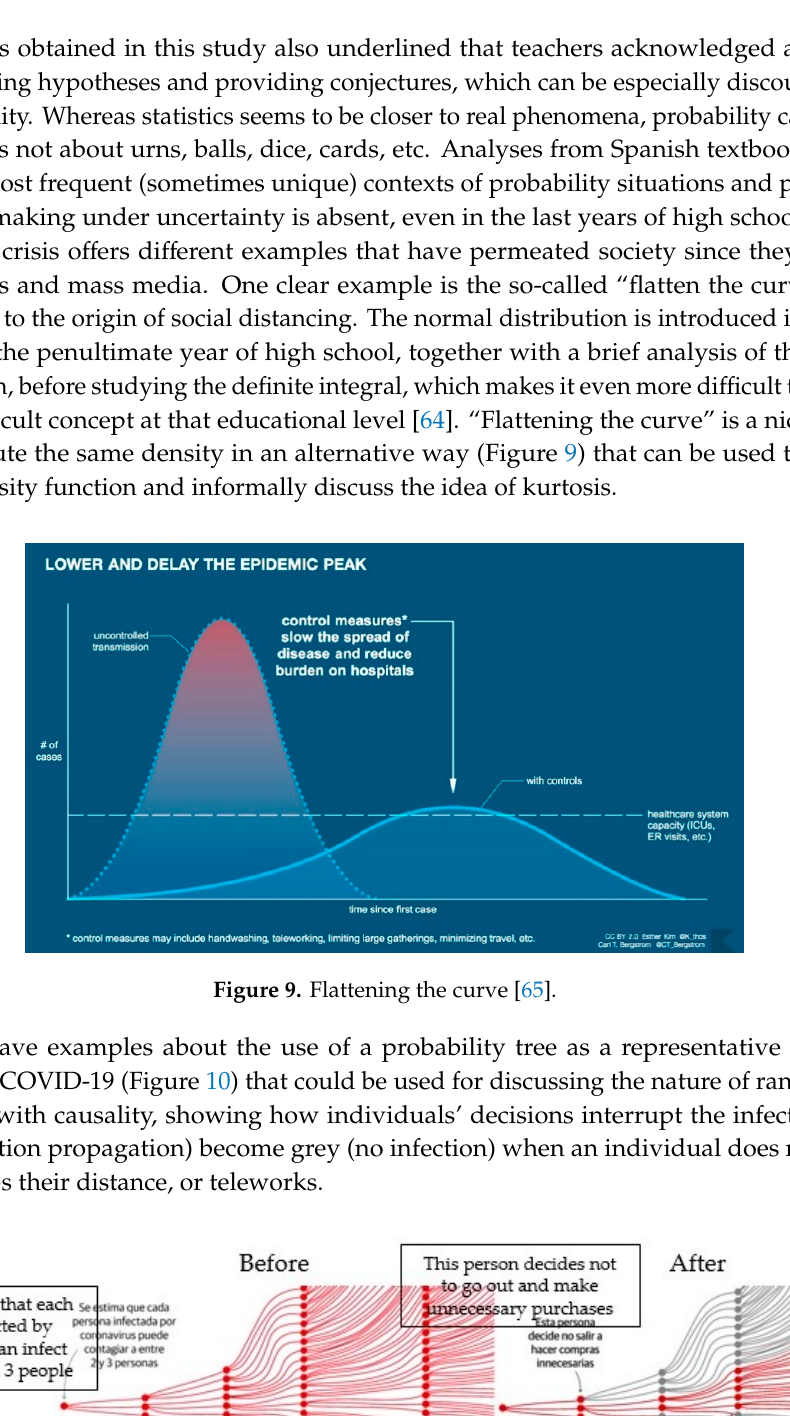
Figure 8. Choropleth representing in red-scale the number of diagnosed cases in Europe, per country, by 20 April 2020 [62]. A period is used to indicate the decimal place.